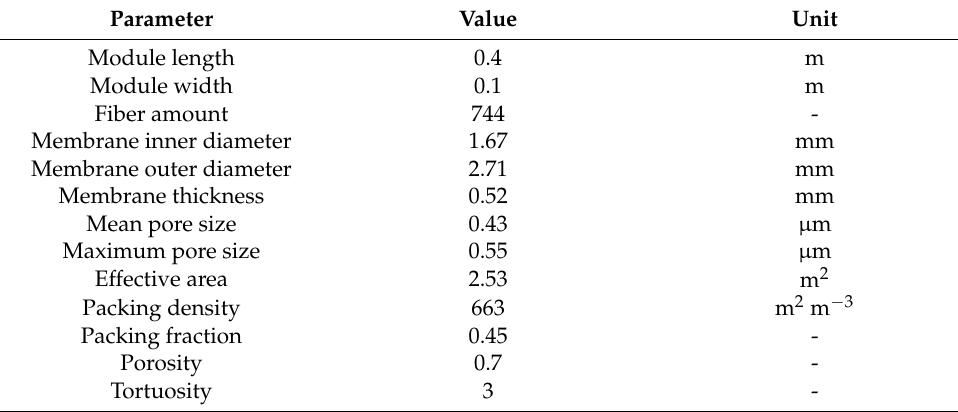
Figure 1. Membrane module: ( a ) Schematic; ( b ) View. Table 1. Specifications of the membrane module.